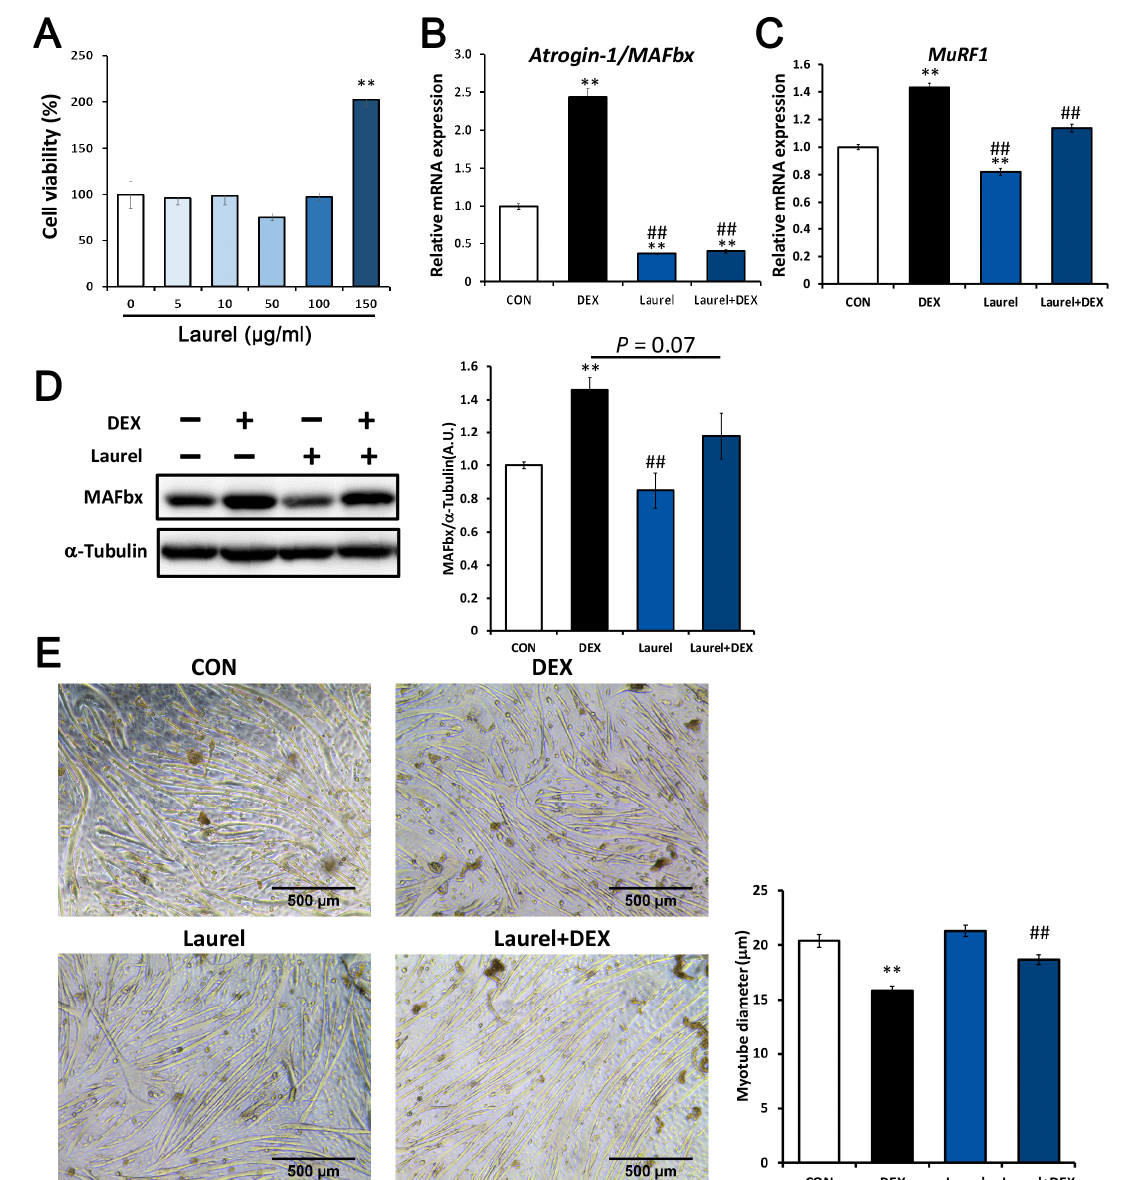
Figure 2. Laurel ameliorates dexamethasone (DEX)-induced C2C12 myotube atrophy by inhibiting the expression of MuRF1 and atrogin-1/MAFbx. ( A ) Effects of laurel on cell viability based on the lactate dehydrogenase (LDH) assay. ( B , C ) mRNA expression of atrogin-1/MAFbx and MuRF1. ( D ) Protein levels of atrogin-1/MAFbx by Western blotting; for densitometric analysis, the band intensity of atrogin-1/MAFbx was normalized to that of α -tubulin ( n = 3). ( E ) Representative images of C2C12 myotubes after treatment with 10 nM DEX and/or laurel (50 µ g/mL). A comparison of the myotube diameter in the four treatment groups is shown on the right. Data are shown as the mean ± SE ( n = 4). ** p < 0.01 vs. control group. ## p < 0.01 vs. DEX